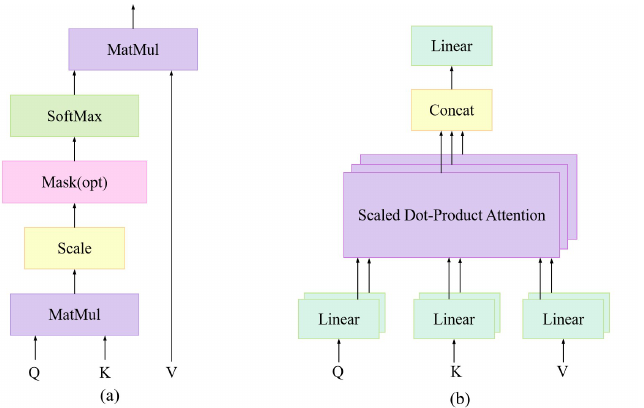
Figure 6. ( a ) is the scaled dot-product attention module, and ( b ) is the multi-head attention